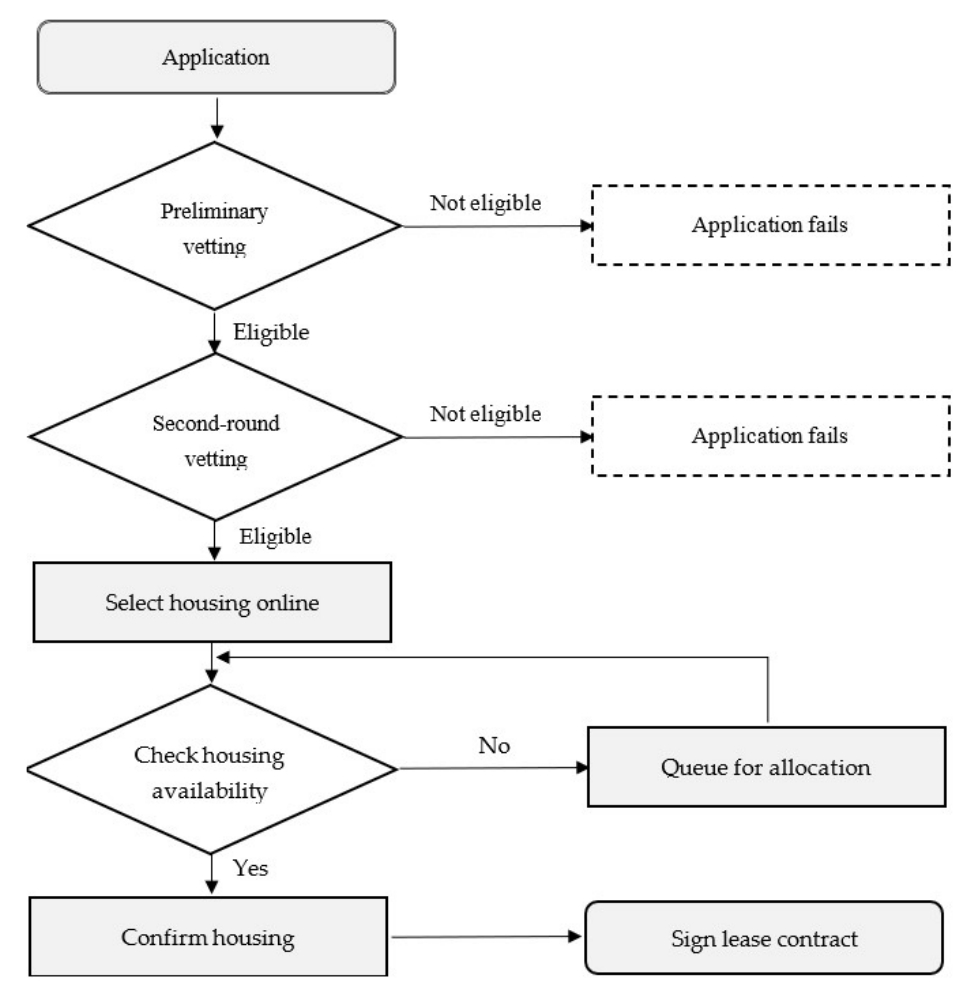
Figure 2. Application procedure for talent apartments (Source: the authors). The complex is well-equipped with sports facilities, open spaces, and green belts. A total of 564 apartments are provided, which are mainly small-sized (area: 45 square me- ters). The monthly rent ranges from CNY 1000–1500 (USD 157–235), depending on the floor and the usage type of the apartment (public rental housing or talent housing). The rent for talent qualified by the district government can be as low as CNY 990 (USD 155) per month.